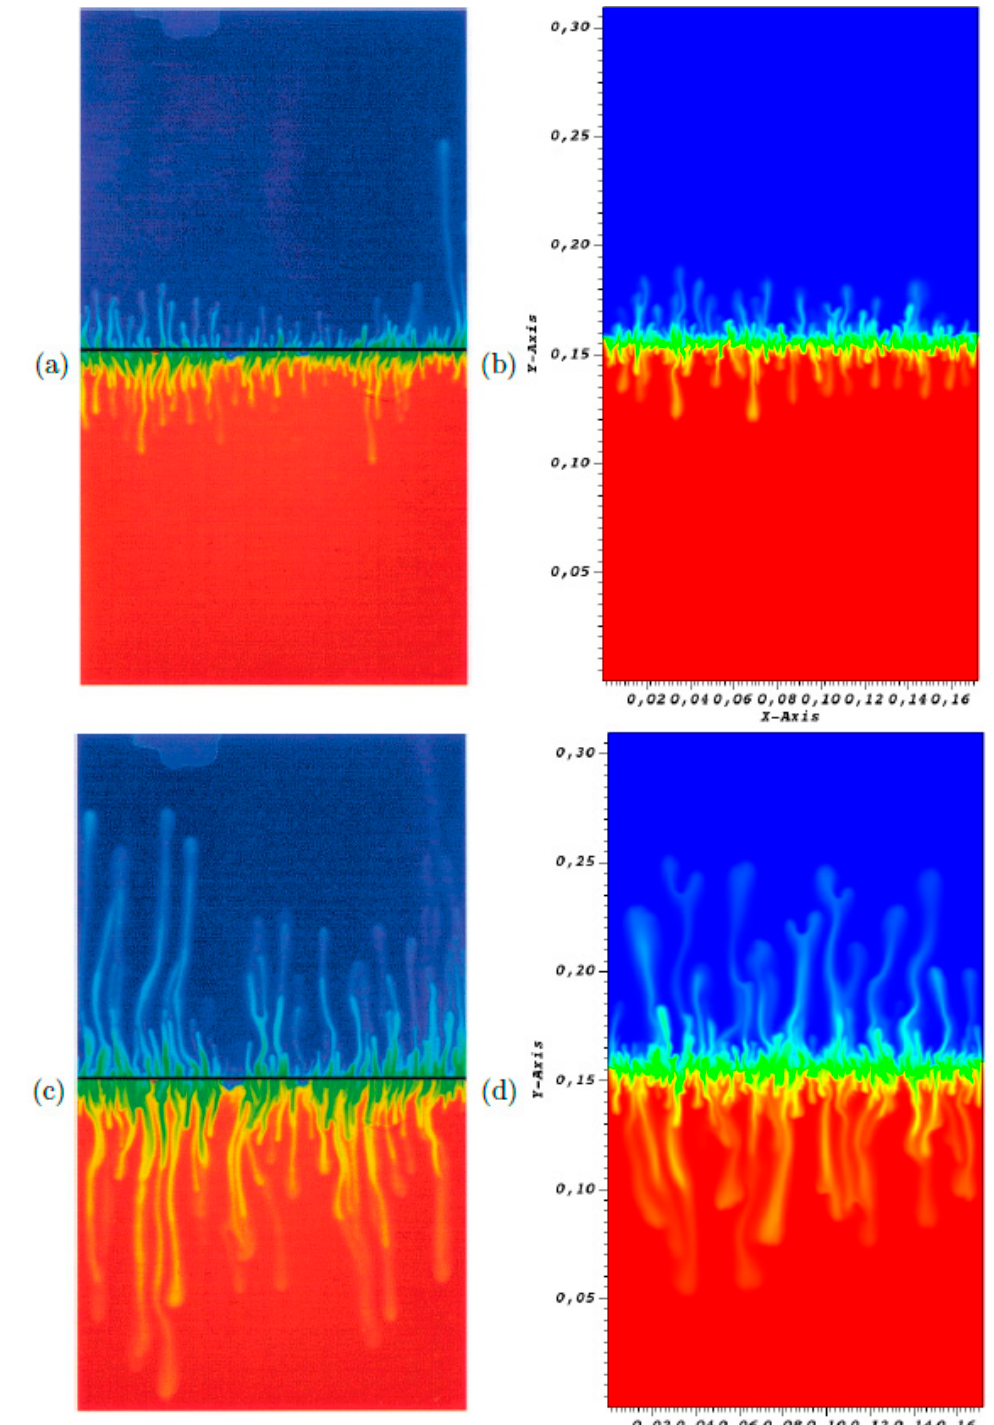
Figure 1. Normalized sucrose concentration for R ρ = 1.4. The normalized concentration ranges from zero (red) to one (dark blue). ( a ) Experimental data [42] at t = 52 min; ( b ) Numerical results at t = 52 min; ( c ) Experimental data [42] at t = 166 min; ( d ) Numerical results at t = 166 min.